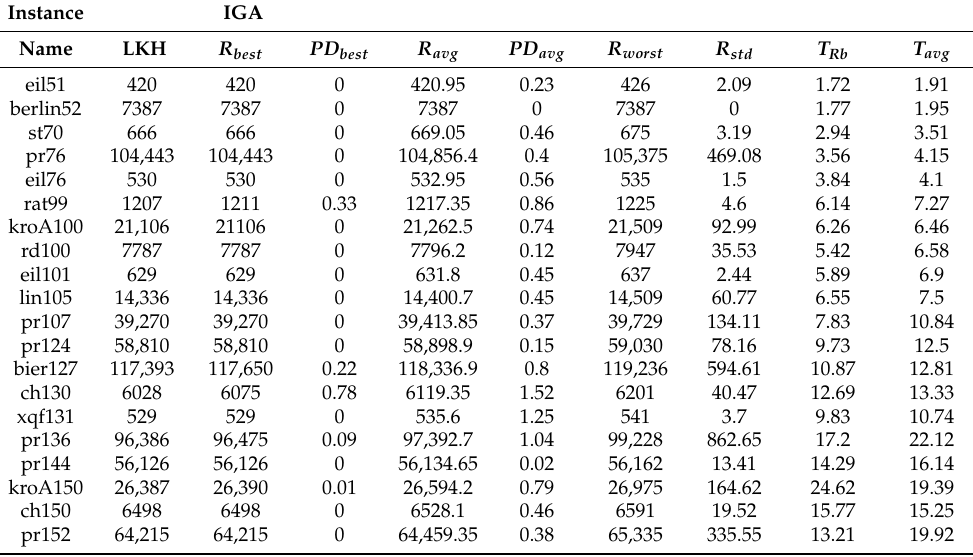
Figure 5. Comparison of the convergence speed of IGA, GA, and ACS on eil51 ( a ), lin105 ( b ), ch150 ( c ) and pr226 ( d ). Table 3. Results obtained by IGA on 42 small-scale